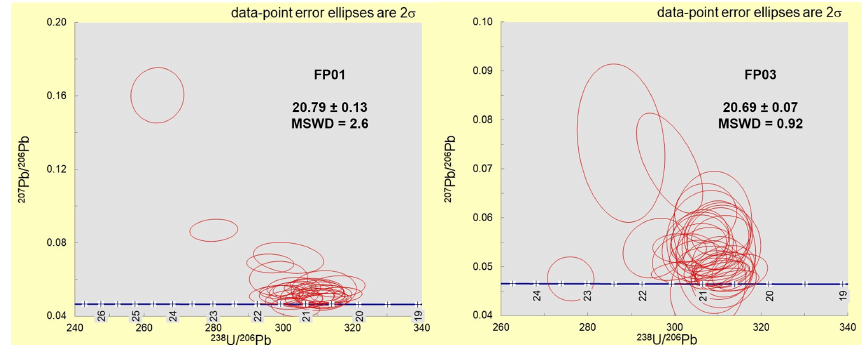
Figure 7. Tera–Wasserburg plots for the two U–Pb analyses completed for this study. Numbers on the reference concordia traces are millions of years.